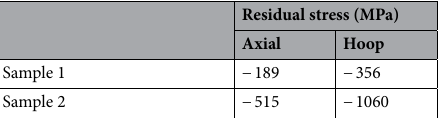
Figure 7a,b show neutron transmission images of Sample 1 and Sample 2 accumulated over wavelengths ranging from 3.46 to 4.51 Å across the BCC 110 edge measured by the MCP detector. Concentric dashed partial circles represent the distances from the tooth tip to the center of the gear of 0, 4, 8, 12, 16, and 20 mm. The gear thickness in the region corresponding to distances of 0 to 10 mm from the tooth tip was 15 mm, and the thickness of the rest of the gear was 20 mm. In this paper, these regions are referred to as the tooth region and the core region. The transmission in the tooth region of each sample was significantly